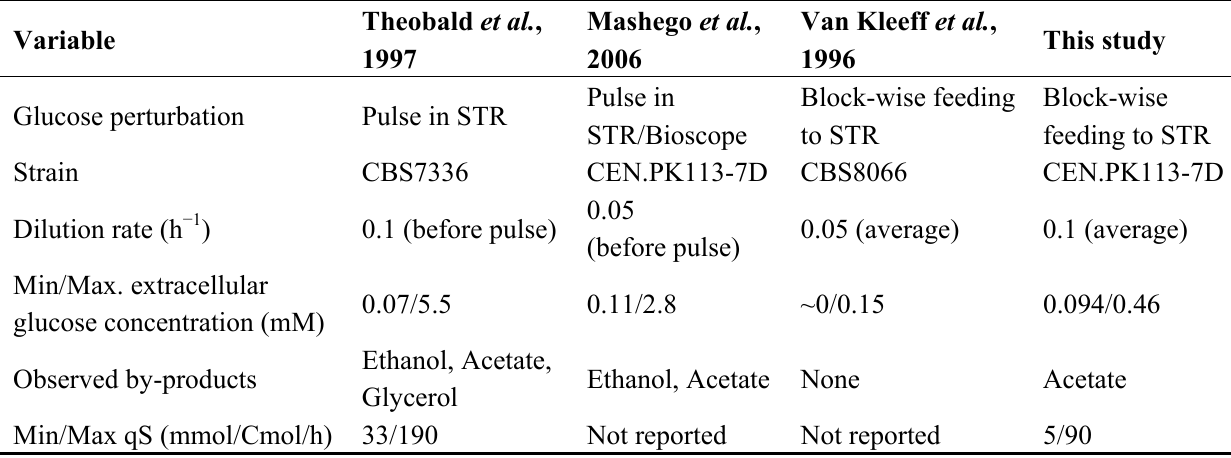
Table 2. Comparison of four different stimulus-response experiments with aerobic cultures of S.